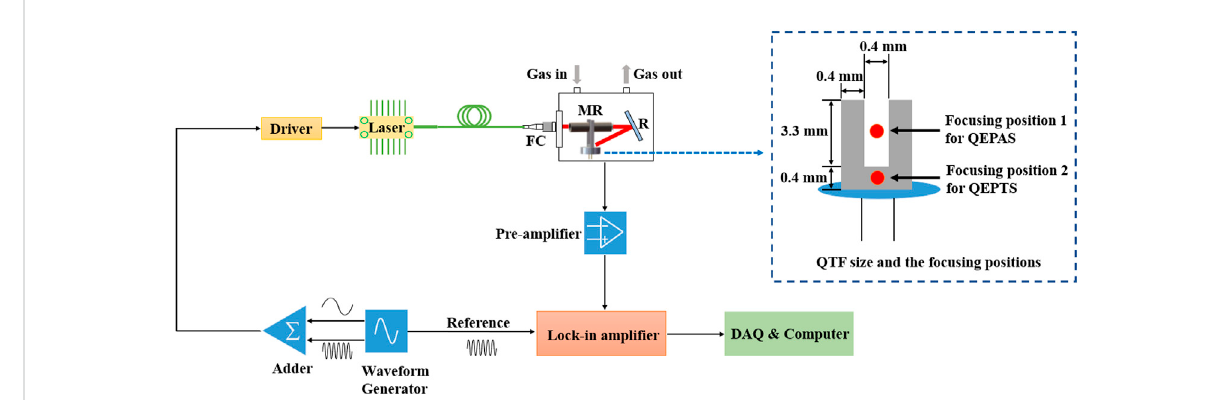
FIGURE 1 Schematic diagram of the experimental setup. FC: fi ber collimator; MR: micro-resonators; R: re fl